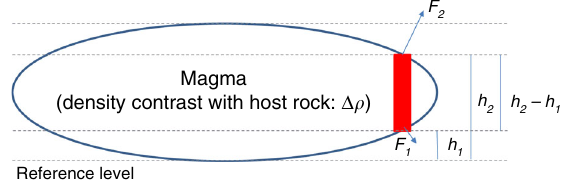
Fig. 3 Buoyancy modelled as traction on boundary of a magma body. Overpressure is calculated with reference to the deepest point of the magma body. This pressure is transferred to a surface force at the boundary, in a direction normal to it. The vertically directed upward force on the column shown in red is Δ A Δ ρ g ( h 2 – h 1 ). Here Δ A is a horizontal cross-sectional area element, equal to (cos φ ) δ A, where φ is the local angle that the boundary of the magma body makes with respect to horizontal. The integrated upward force due to all columns in the magma body gives an overall upward force following Archimedes law. For this geometry, the integrated horizontal force on the entire boundary will be zero (cancels out for this geometry because of symmetry).